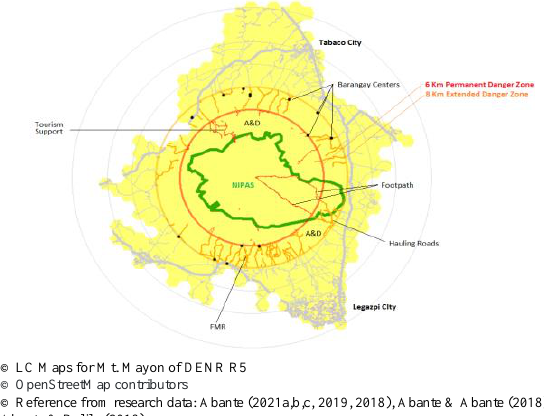
Figure 6 . Road-stances within the study area